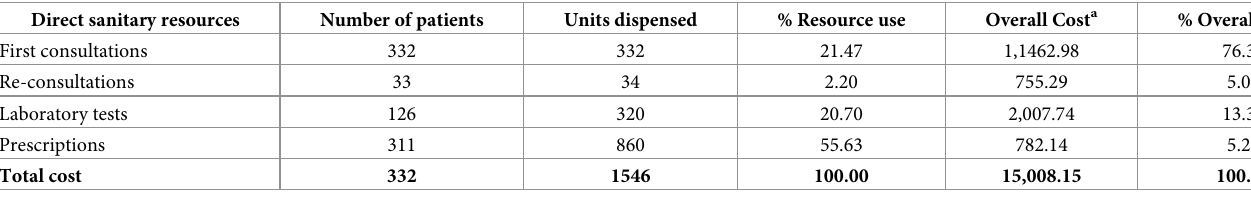
Table 4. Total resource use and overall cost of direct sanitary resources.